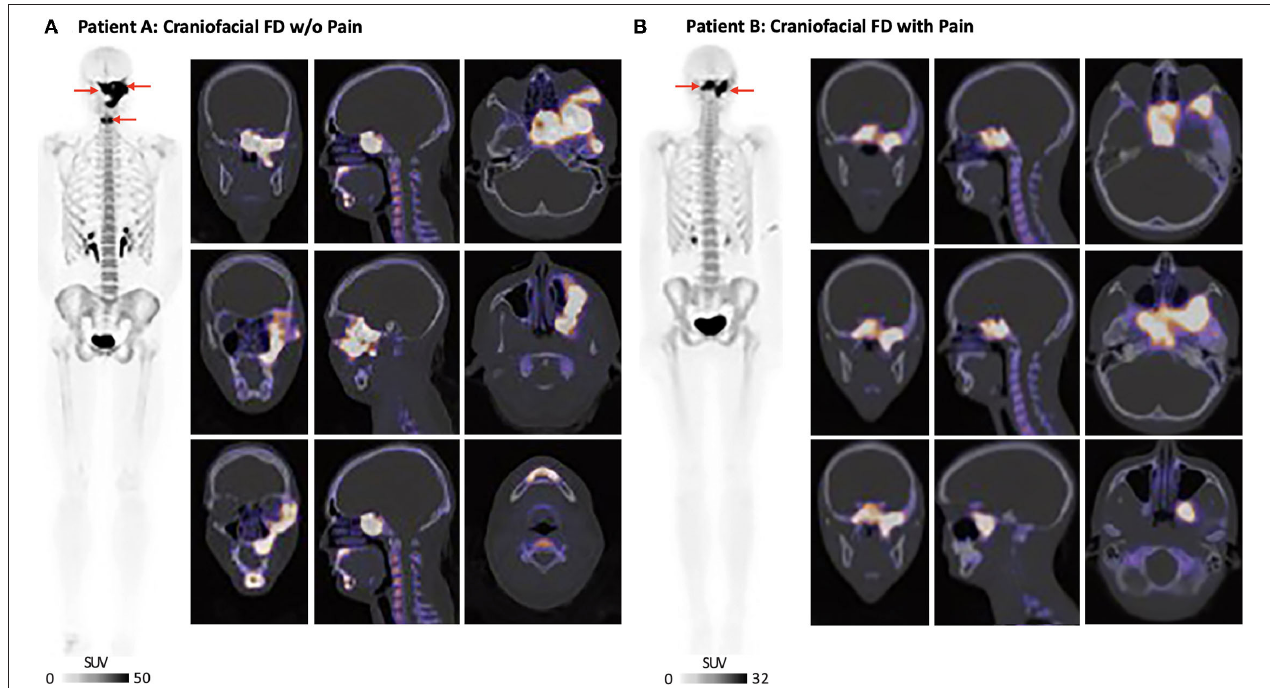
FIGURE 2 | Craniofacial FD burden and severity. (A) Patient A: 18 F-NaF PET/CT showed intense radiotracer uptake in the left frontal bone and zygomatic arch, left maxilla, left sphenoid bone, and livus. There was also involvement of the anterior mandible. (B) Patient B: 18 F-NaF PET/CT showed intense uptake involving the base of the skull, clivus, sella and left sphenoid bone. The patient also had scattered areas of increased uptake in the left temporal bone with SUV max = 13. All 18 F-NaF PET/CT data were read by a board-certified nuclear medicine physician (Dr. Drubach).